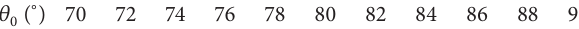
Table 3: Different angles of the loads in the second